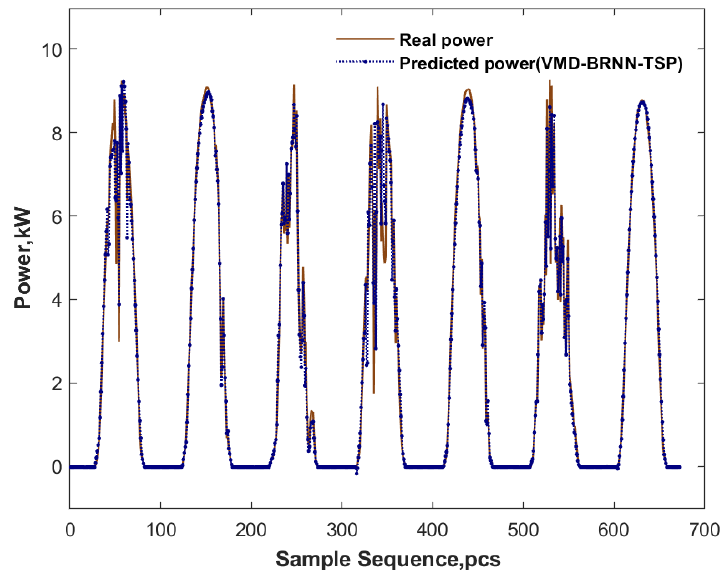
Figure 7. VMD-BRNN-TSP model prediction results.